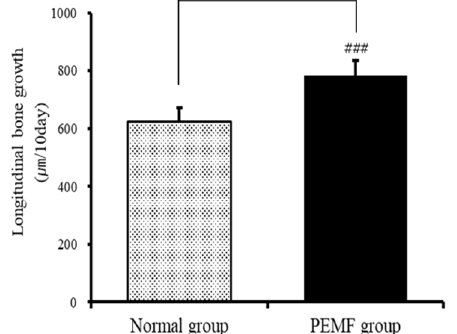
Figure 5. Effects of PEMF treatment on bone growth rate in the proximal growth plate of the tibia. Results are expressed as means ± SEM (n = 8). ### p < 0.001 compared with the normal group.